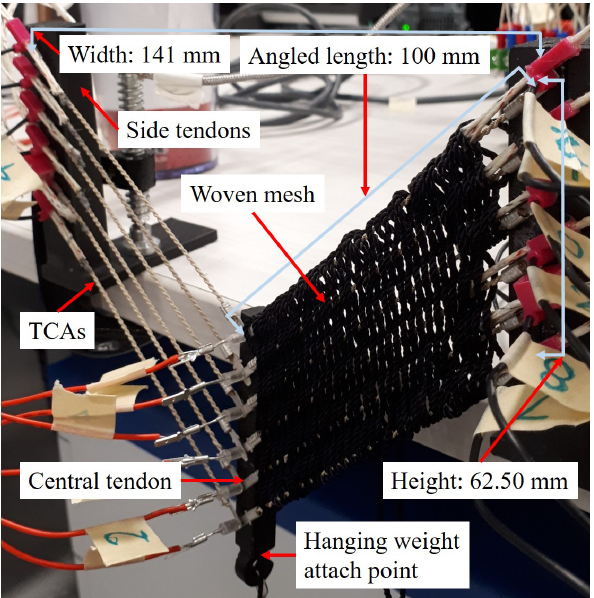
Figure 3. Actuator in the process of being woven. The right side has been completely woven, while the left has yet to be